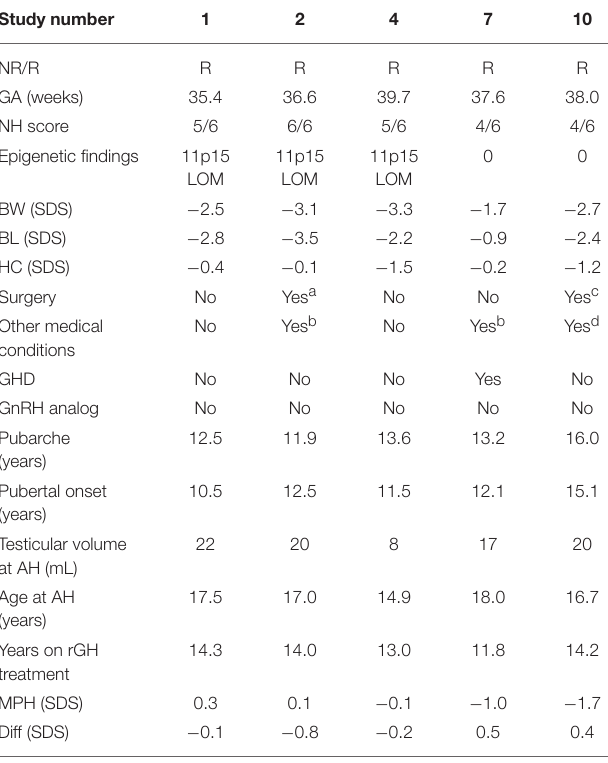
TABLE 2 | Patient characteristics for responders (R).